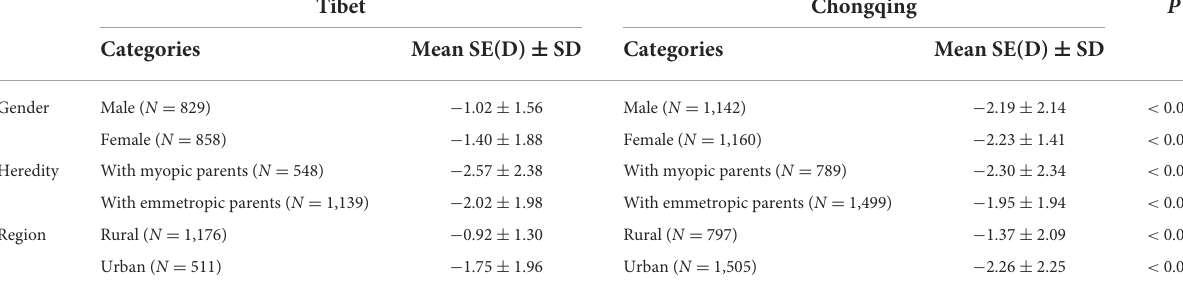
TABLE 2 The mean uncorrected visual acuity and spherical equivalent refraction with demographic factors. Tibet